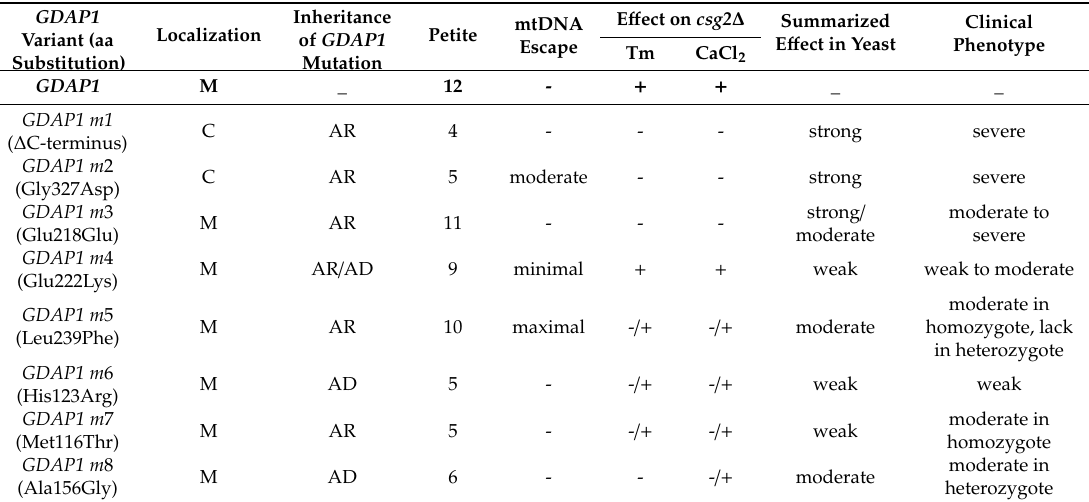
Table 2. Pathogenic e ff ect of GDAP1 gene